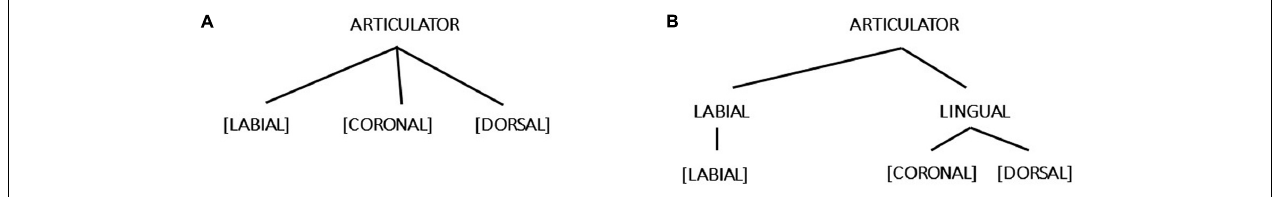
FIGURE 8 | Relevant features [ LABIAL ], [ CORONAL ], and [ DORSAL ] in the feature tree of the FUL-model (A) , and the revised model proposed in this paper (B) .